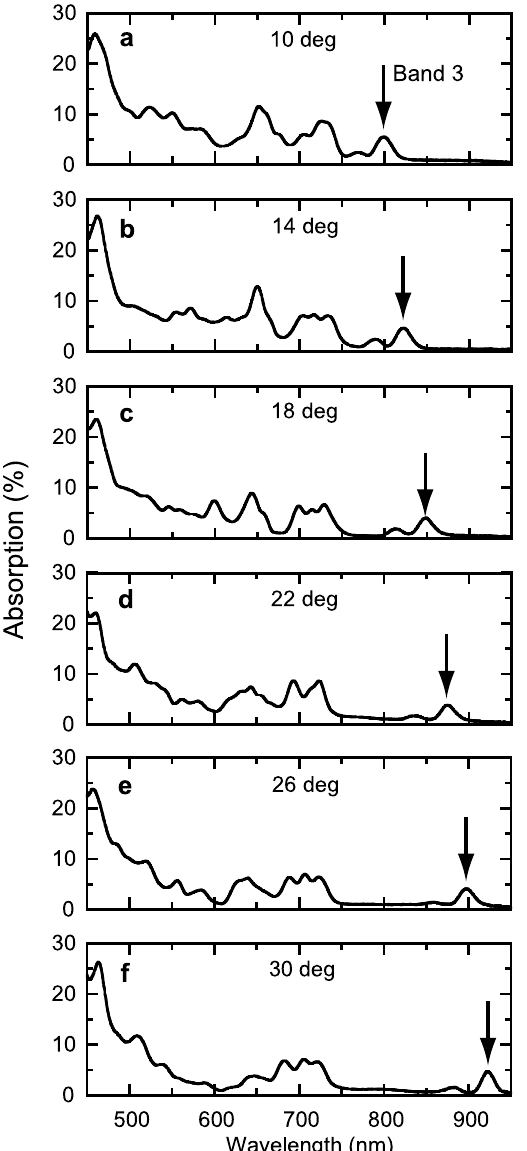
resonance in each